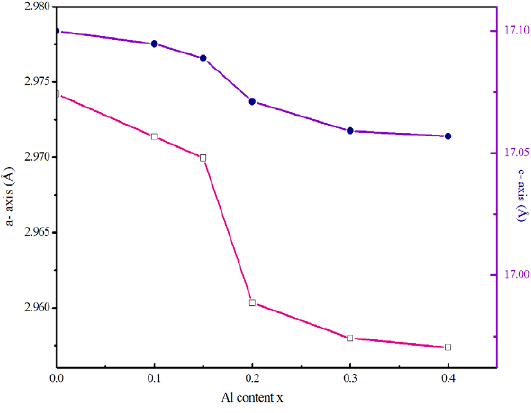
Figure 2. lattice constants evolution with the Al content Al O 1-x x 2